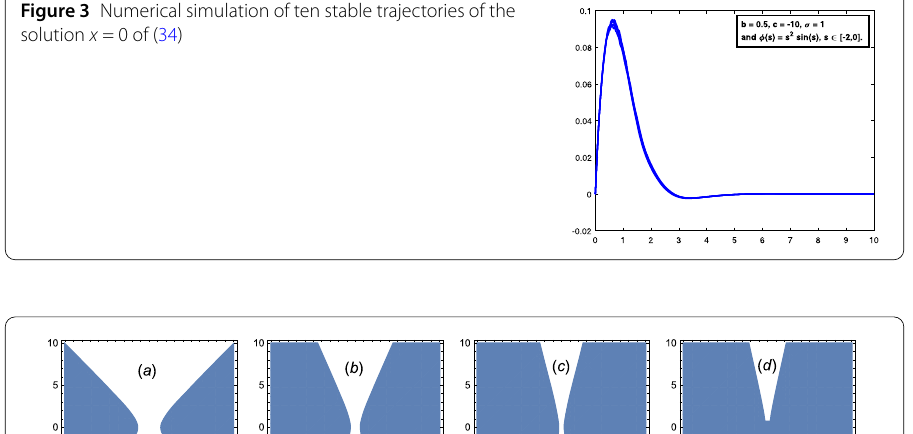
Figure 3 Numerical simulation of ten stable trajectories of the solution x = 0 of (34)